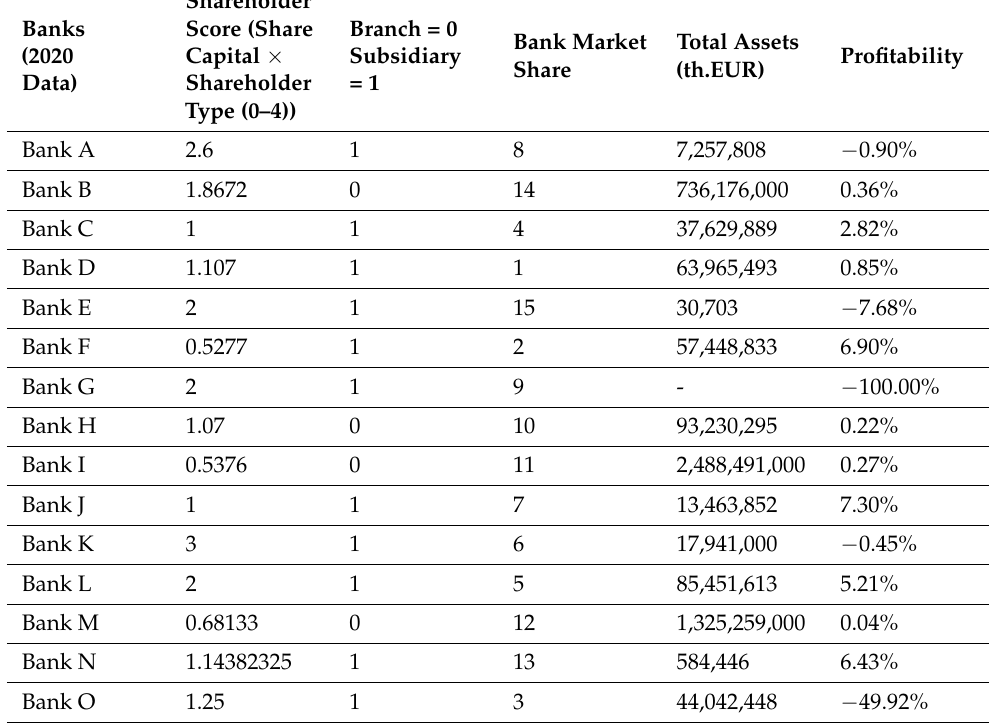
Table 2. Variables associated with bank